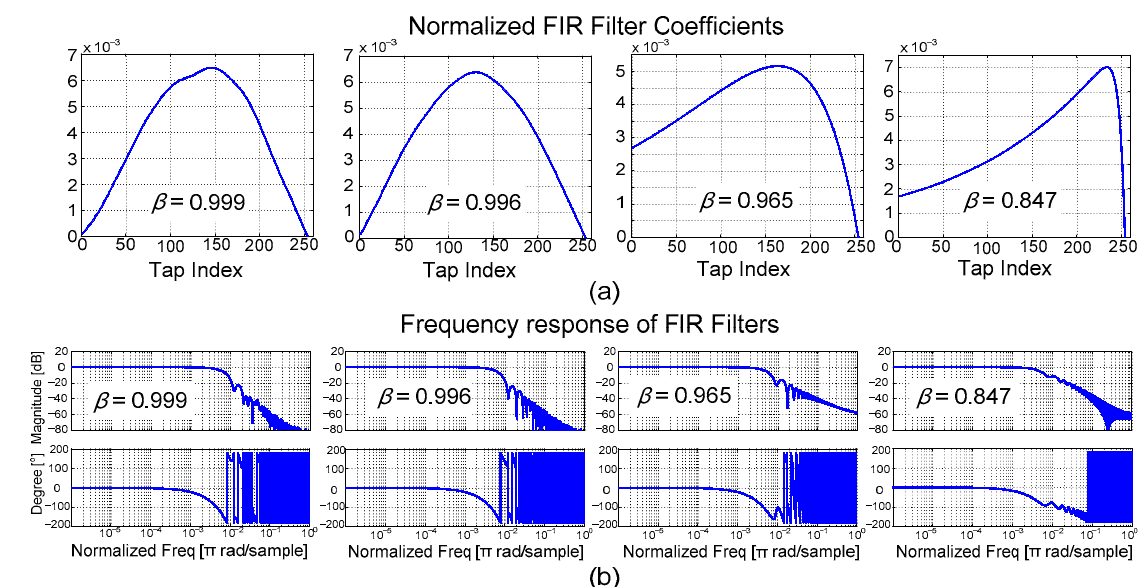
Figure 5. ( a ) Normalized optimal filter coefficient for various leakage values and ( b ) corresponding magnitude and phase response of the filter in frequency-domain.